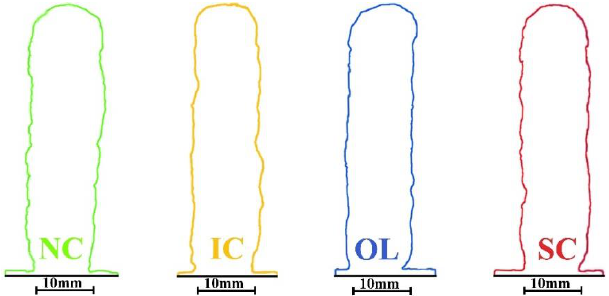
Figure 7. Section outline of as-deposited 5356 walls by different cooling processes.